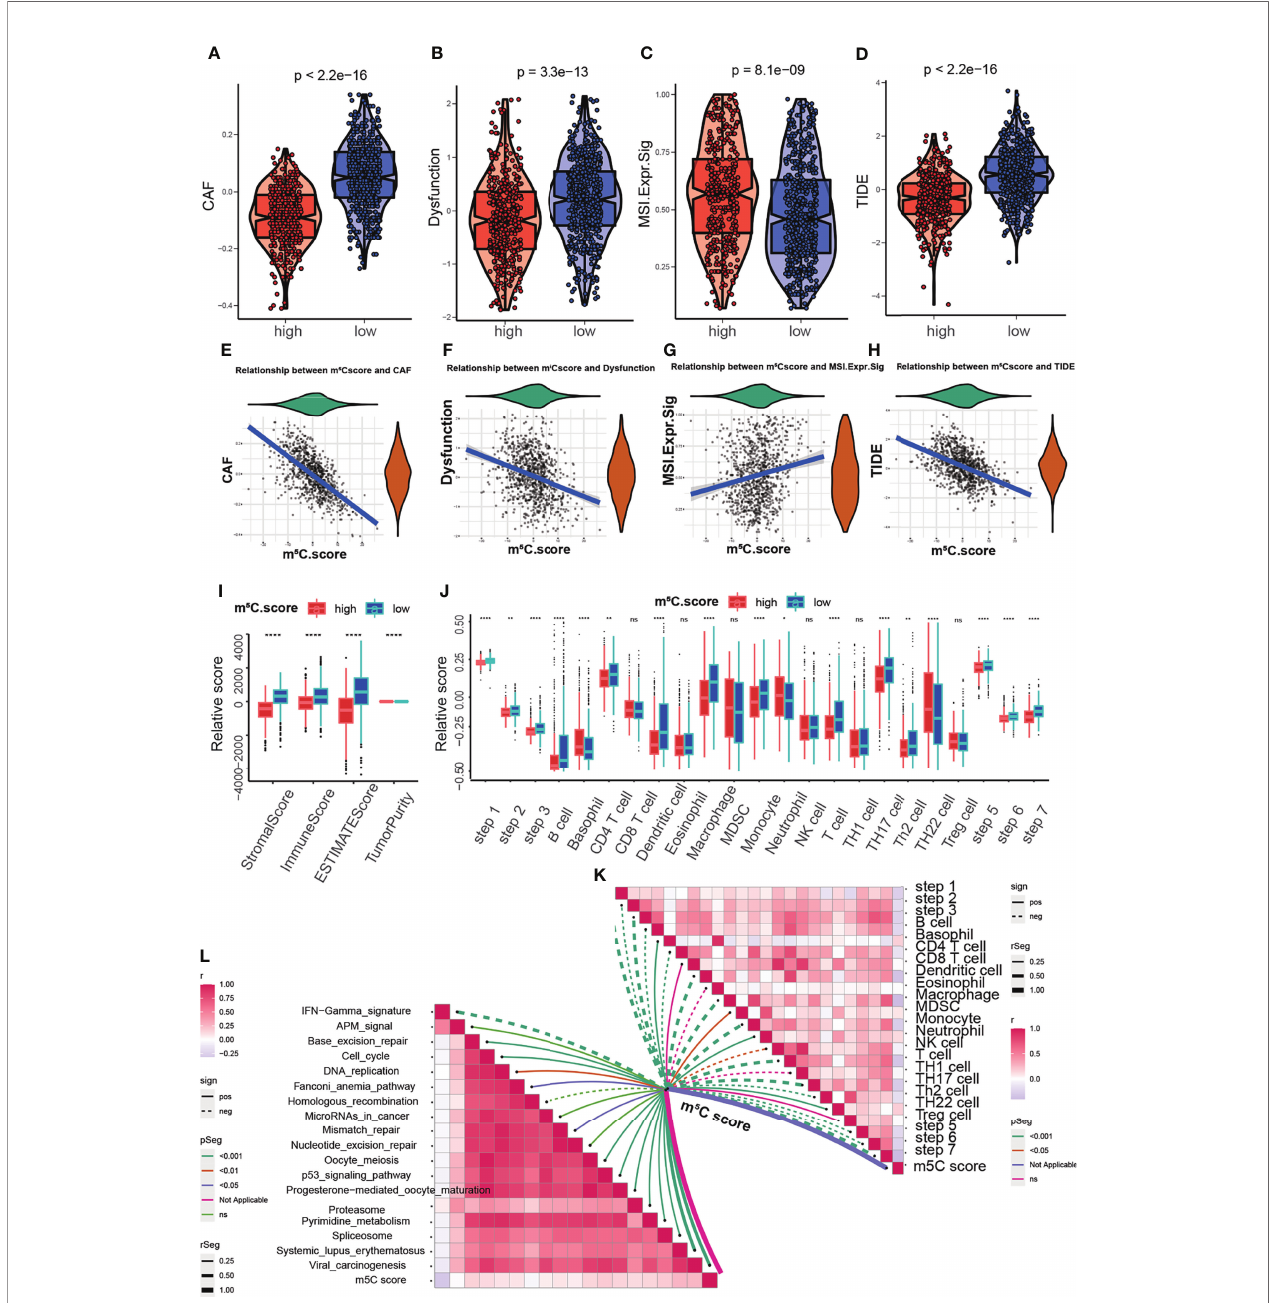
FIGURE 6 | Analysis of the correlation between the m 5 C score and the immune microenvironment. (A, E) Correlation between the m 5 C score and cancer- associated fi broblasts (CAFs). CAF t Student (928)=-24.87, p=4.69e-105, r pearson =-0.63, CI 95% =[-0.67, -0.59], n pairs =930. (B, F) Correlation between the m 5 C score and T cell dysfunction. Dysfunction t Student (928)=-9.50, p=1.78e-20, r pearson =-0.30, CI 95% =[-0.36, -0.24], n pairs =930. (C, G) Correlation between the m 5 C score and microsatellite instability (MSI). MSI.Expr.Sig t Student (928)=-5.36, p=1.03e-07, r pearson =0.17, CI 95% =[0.11, 0.24], n pairs =930. (D, H) Correlation between the m 5 C score and the TIDE score. TIDE t Student (928)=-16.37, p=3.92e-53, r pearson =-0.47, CI 95% =[-0.52, -0.42], n pairs =930. (I) Correlation between the m 5 C score and the stromal score, immune score, ESTIMATE score and tumor purity. (J, K) Correlation between MBS and the steps of the cancer immunity cycle. (L) Correlation between MBS and the enrichment score of immunotherapy-related pathways. * represents p value < 0.05, ** represents p value < 0.01, **** represents p value < 0.0001, ns means "not statistically signi fi